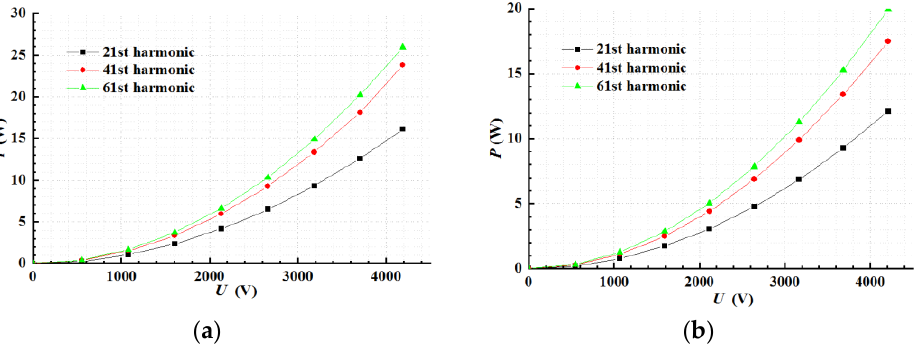
Figure 5. Power variation curve of D71 valve plate. ( a ) Power characteristics of general plate; ( b ) Power characteristics of high-gradient plate.